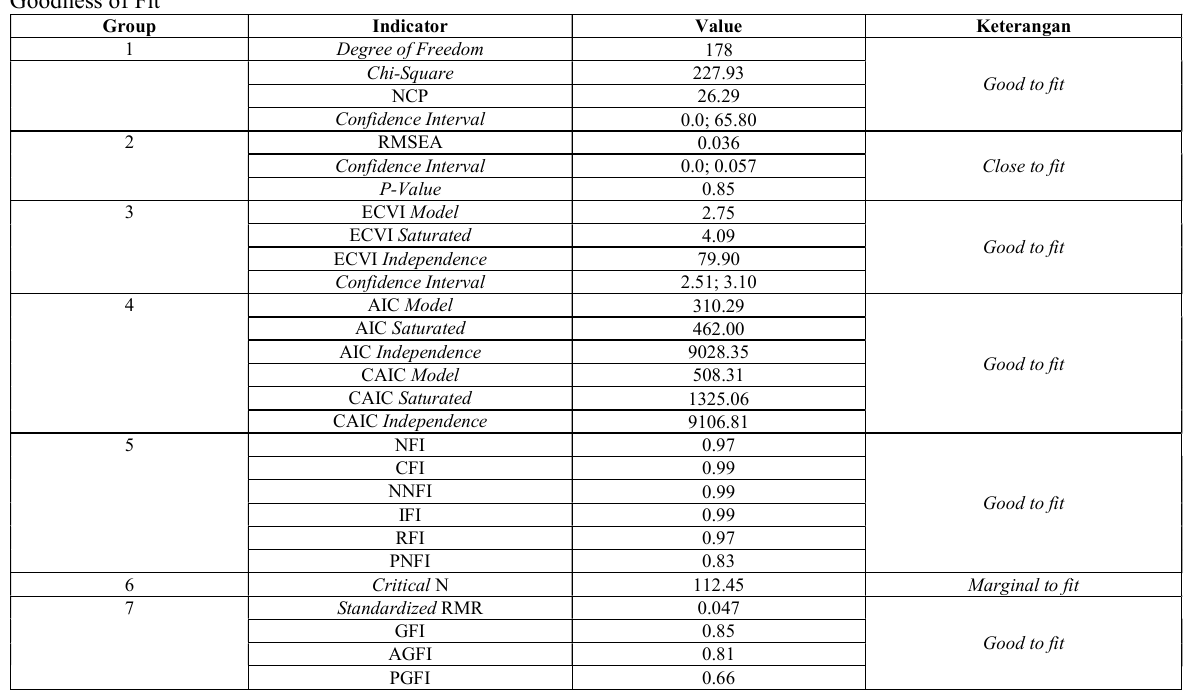
Goodness of Fit